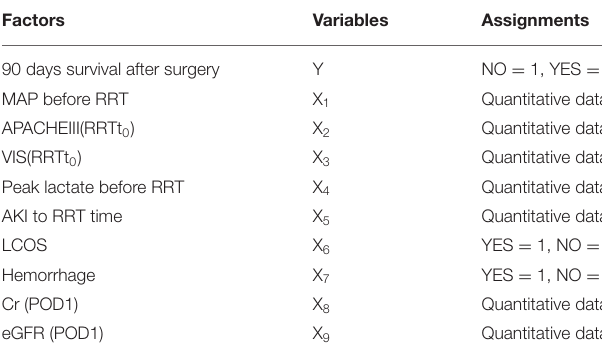
Sensitivity Specificity Youden